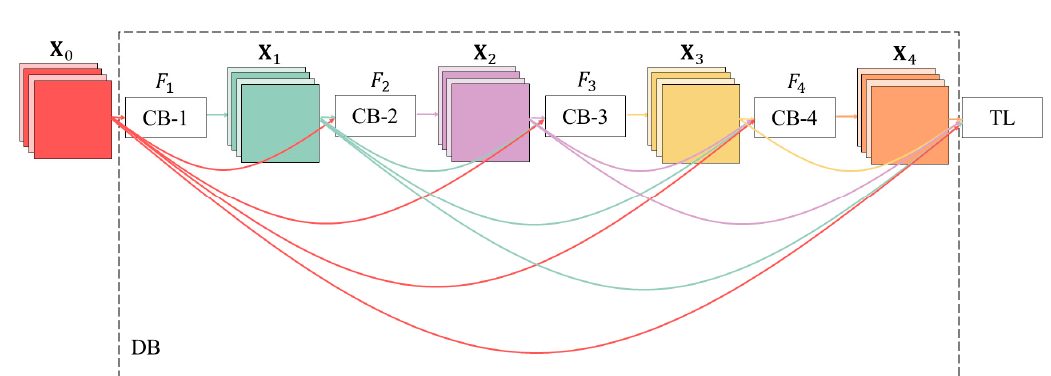
Figure 4. A dense block (DB) composed of four convolutional blocks (CBs).